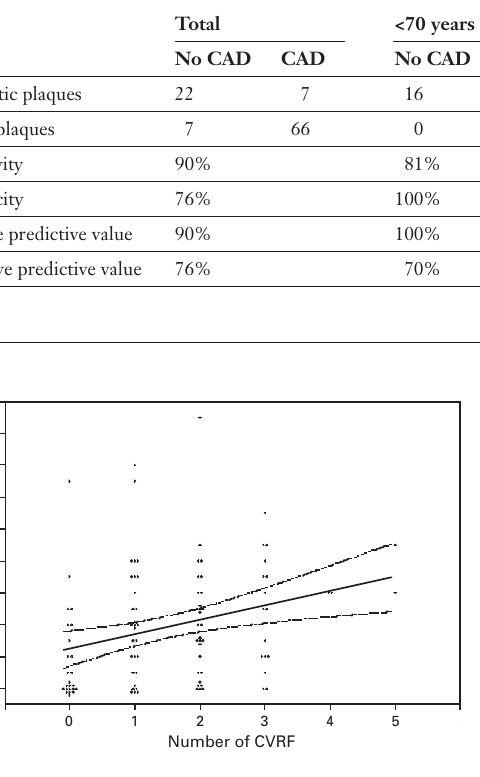
Predictive value of aortic plaques for the presence of CAD.